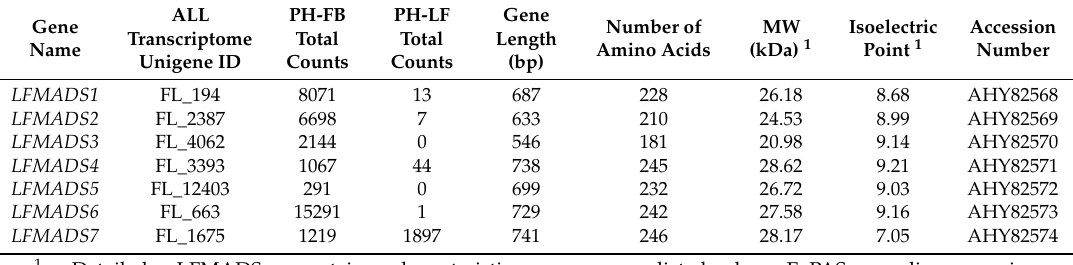
Table 1. Characteristics of seven genes encoding MADS-box proteins identified in L. formosanum